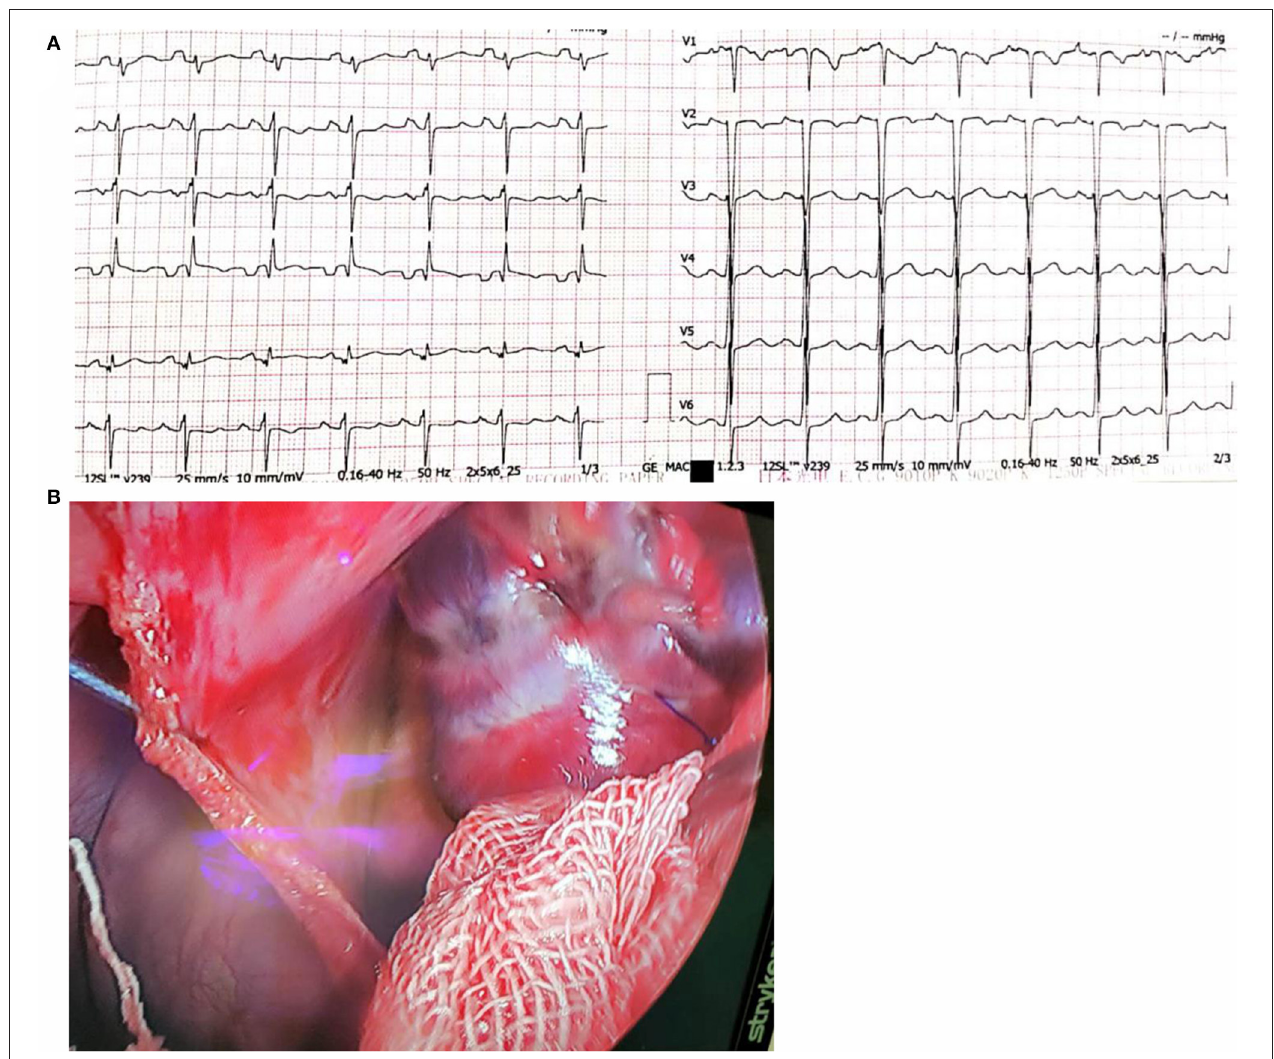
FIGURE 3 | (A) The surface electrocardiogram showing sinus rhythm after surgical ablation; (B) The adventitia scar after ablation of the right atrial appendage under thoracoscopic